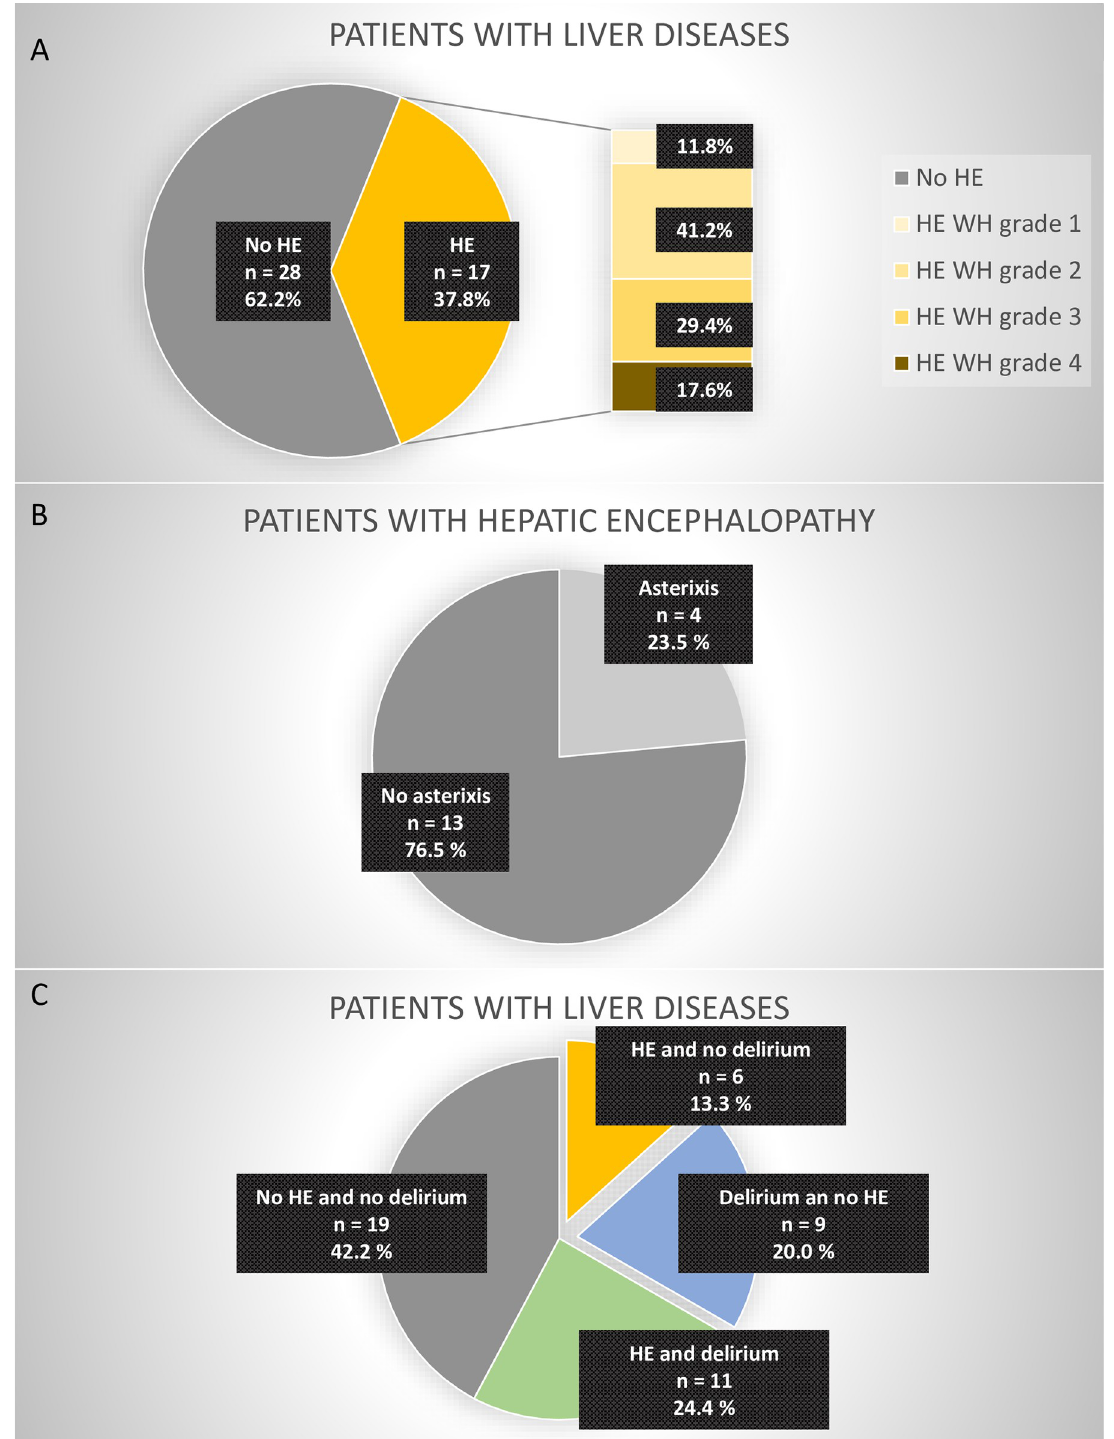
Fig 5. A: Hepatic Encephalopathy (HE) classified according to the West Haven (WH) criteria in the subgroup of patients with liver diseases. B: asterixis (= flapping hand tremor) in patients with HE. C: Incidence of delirium and/or HE in the subgroup of patients with liver